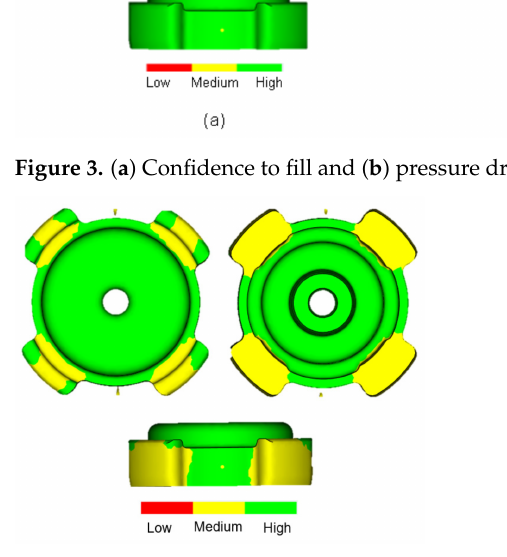
Figure 4. Quality